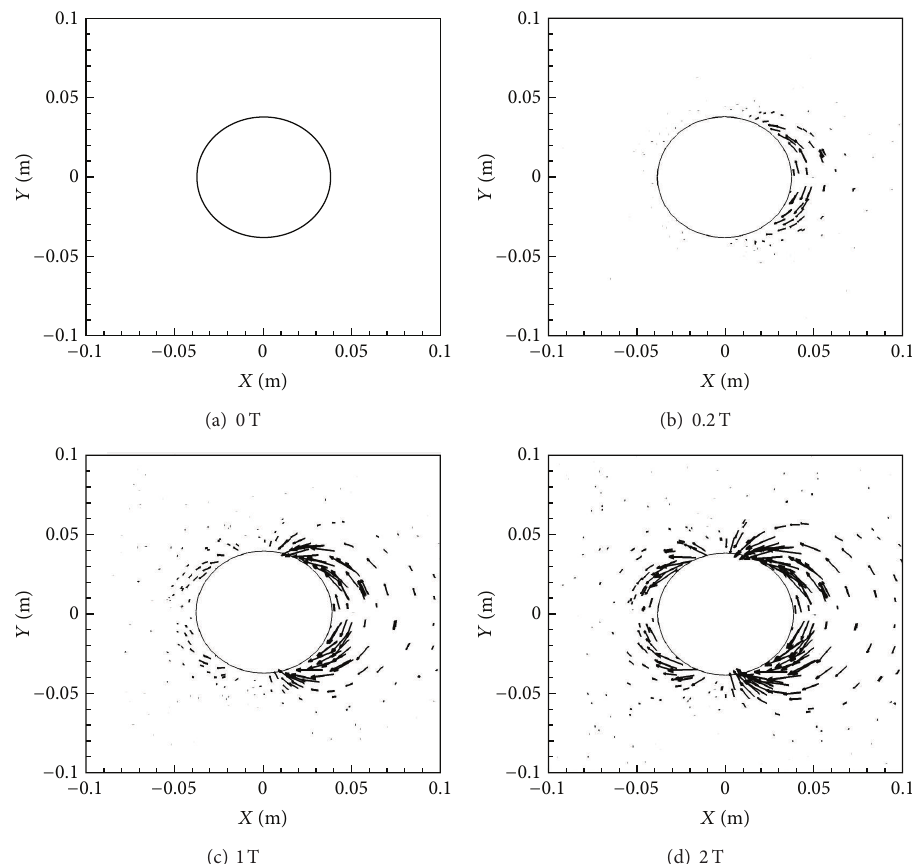
Figure 4: Lorentz force vectors for various 𝐵 max with 𝑋